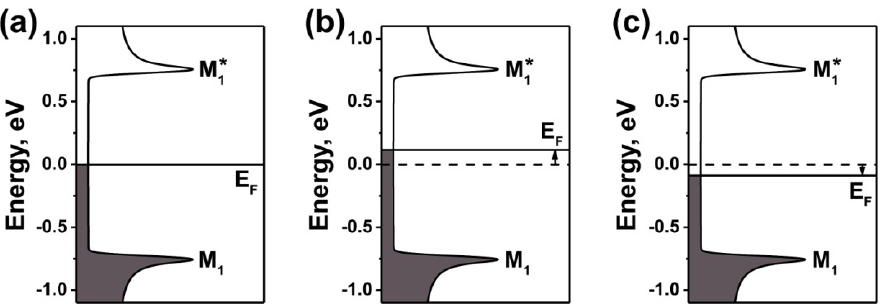
Figure 4. The schematics of the band structures of metallic SWCNTs ( a ) and nickelocene-filled SWCNTs annealed at temperatures of 360–600 °C ( b ) and 680–1200 °C ( c ) for 2 h. E F is the Fermi level, and M1 and M1* are the first vHs in the valence and conduction band, respectively. The Fermi level shift is indicated by arrows.